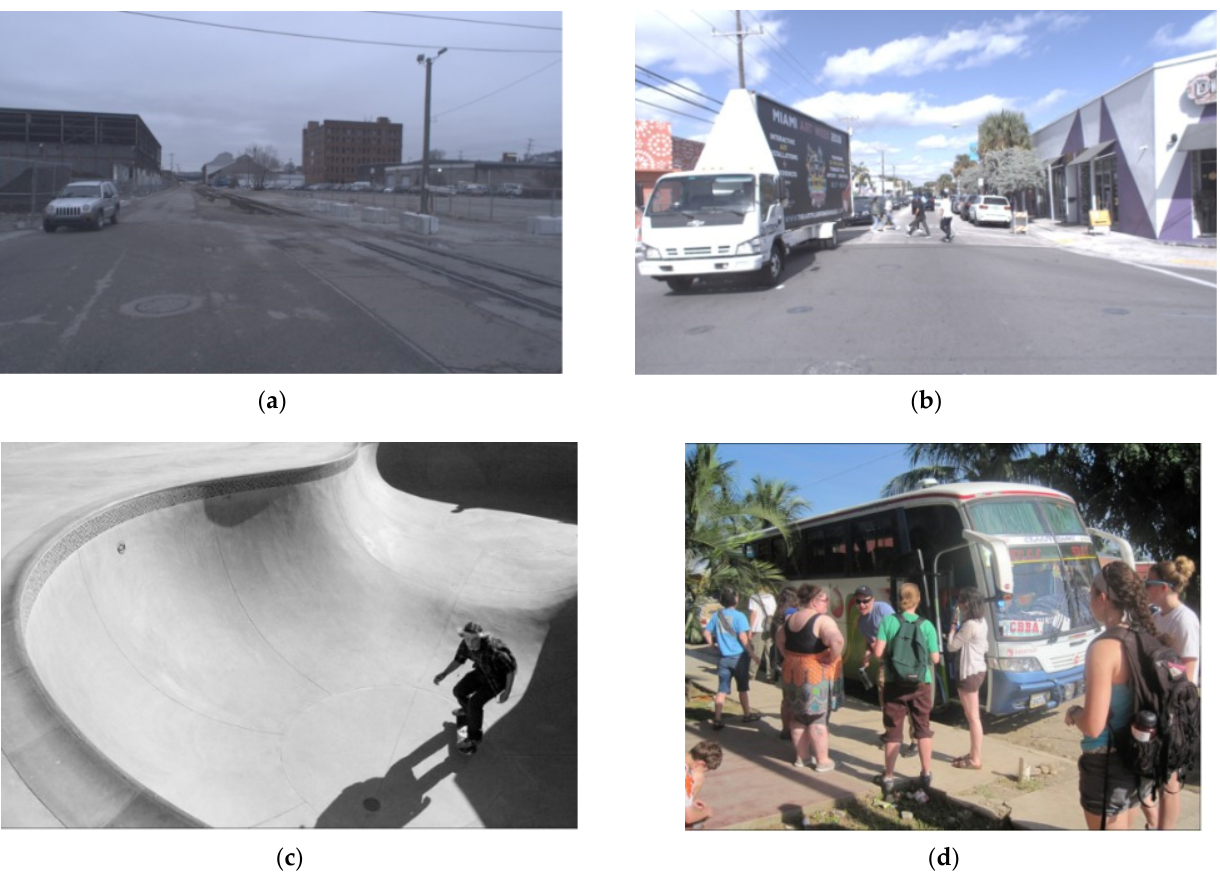
Figure 8. An overview of raw images taken from the two datasets used for training and testing the proposed object detector. Images ( a , b ) denote sparse and dense multi-class objects from the Argoverse-HD dataset in overcast and clear conditions respectively, and images ( c , d ) denote sparse and dense multi-class objects from the COCO dataset in grayscale and RGB color space respectively. These datasets contain multiple images containing objects of different classes, complex scenarios, and diverse lighting.